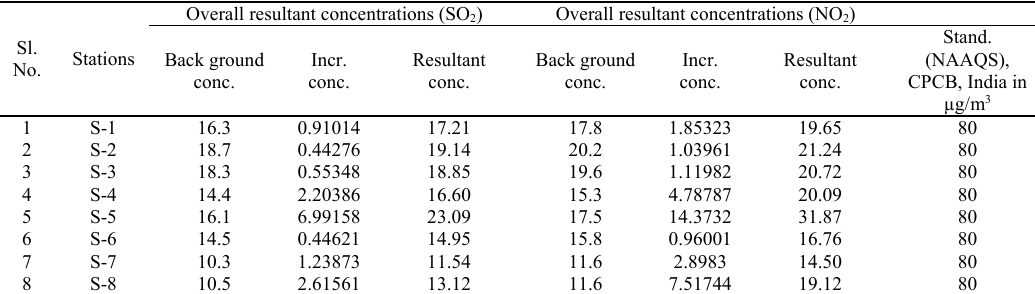
Table 6: Overall resultant concentrations respective to stations for both SO 2 and NO 2 in µg/m 3